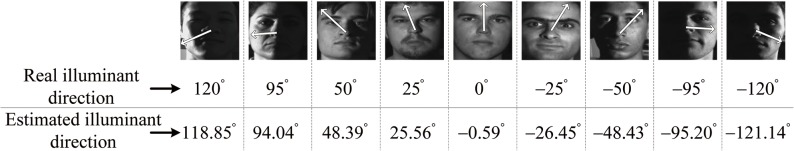
Real illuminant directions and estimated illuminant directions.Reprinted from http://vision.ucsd.edu/~leekc/ExtYaleDatabase/ExtYaleB.html under a CC BY license, with permission from David Kriegman, original copyright 2001.